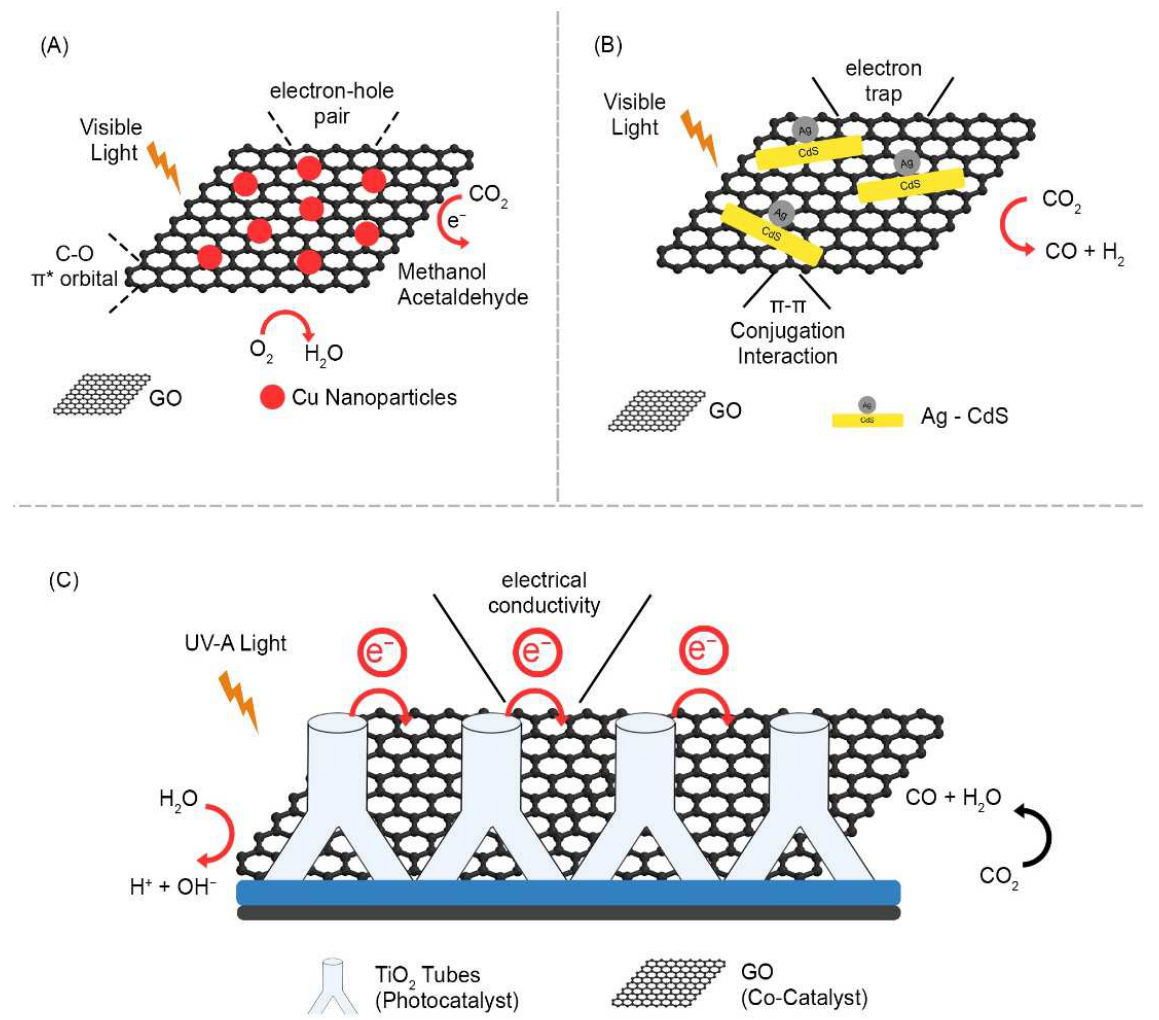
Figure 5. Mechanism of CO 2 reduction in GO metal hybrids: ( A ) Cu [81]; ( B ) Ag-Cds [82]; ( C ) TiO 2 [80].